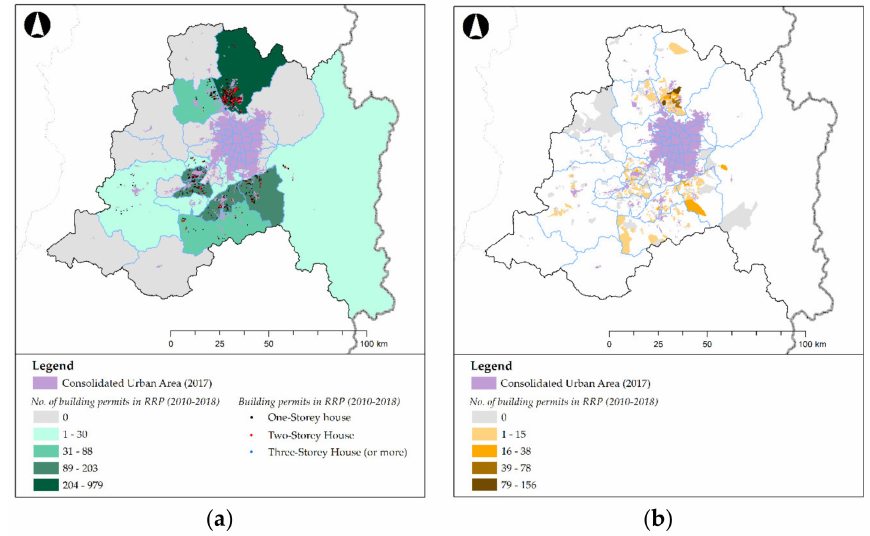
Figure 7. Number and location of RRP building permits between 2010 and 2018 ( a ) by county and ( b ) by sector. Source: Own elaboration, based on INE (2017) and MINVU